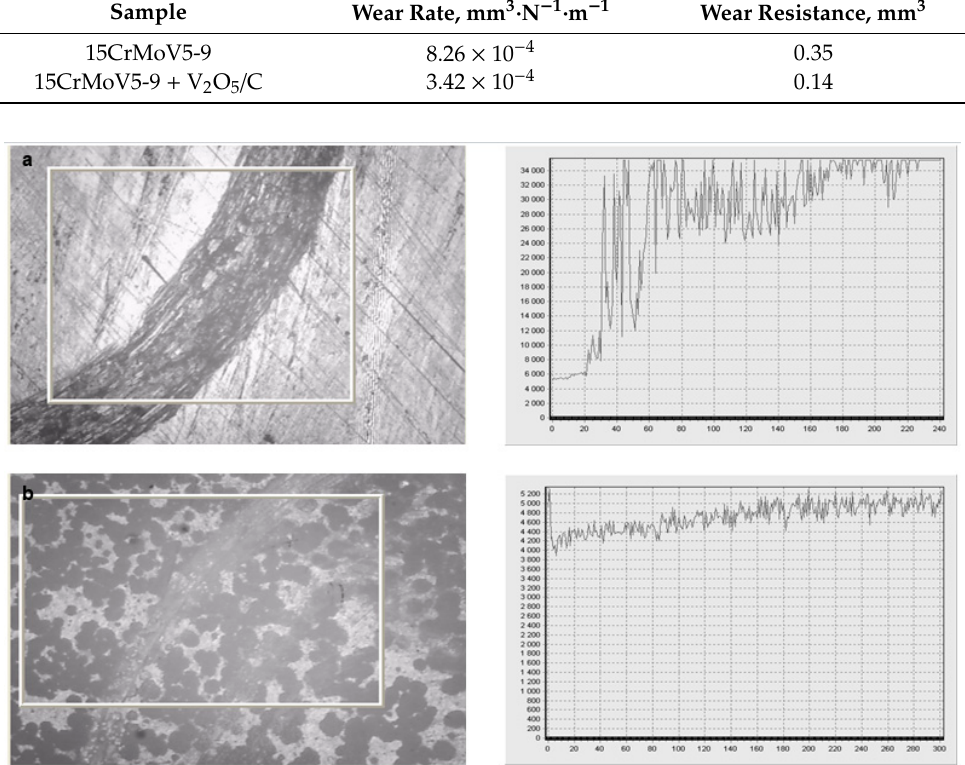
Figure 8. Structure of the friction tracks of the sample and the dependence of the coefficient ( y axis) of friction on the rotation speed (rpm, x axis): ( a ) 15CrMoV5-9 matrix without coating, ( b ) coated with V 2 O 5 /C.